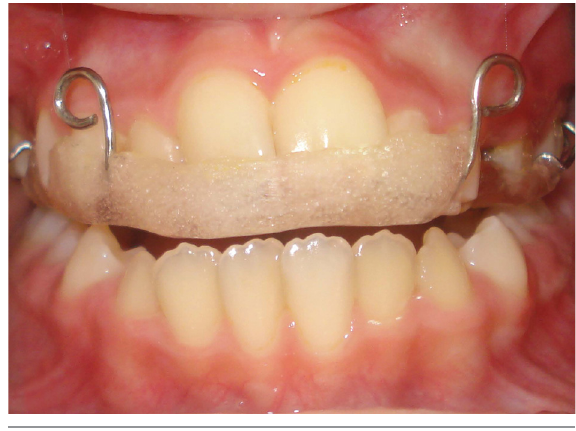
Figure 1. View of intraoral